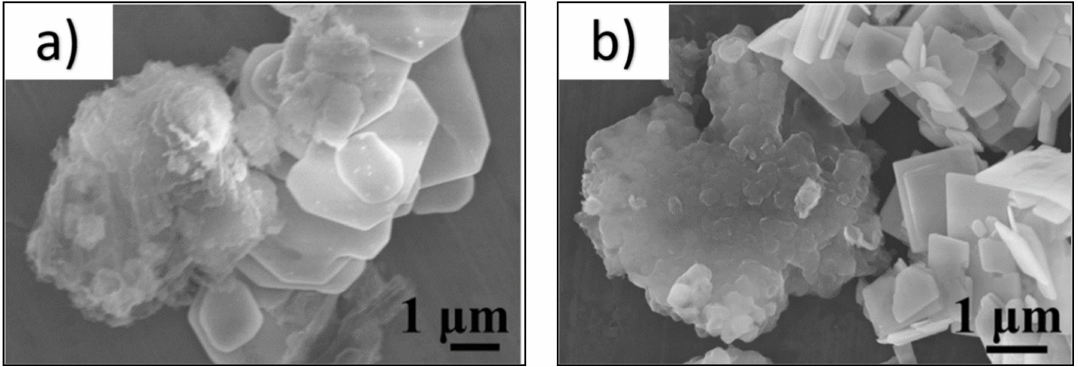
Figure 1. SEM images of ( a ) g-C 3 N 4 /BiOCl-001 and ( b ) g-C 3 N 4 /BiOCl-010. Reproduced with permission from Iqbal W et al, Catalysis Science & Technology; published by Royal Society of Chemistry,